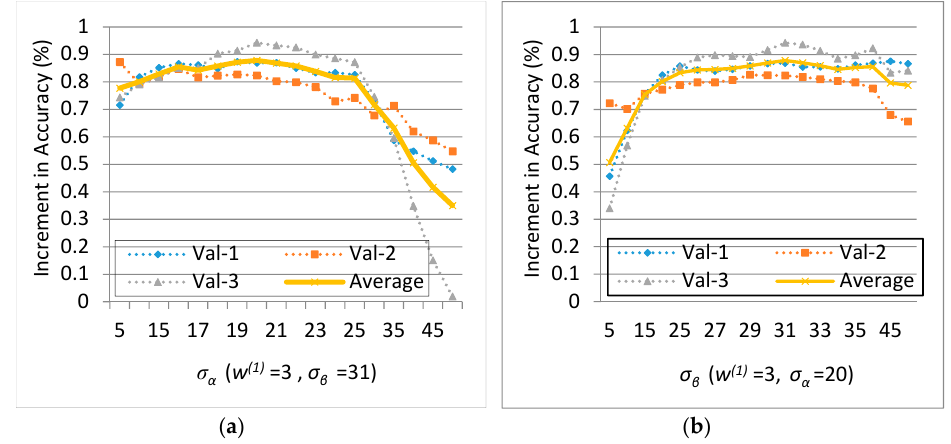
Figure 13. Influence of the hyper parameter values ( w ( 1 ) , σ α and σ β ) on the final classification accuracy. The experiment is implemented on the 3 tiles (named Val-1, Val-2 and Val-3) of the validation set. ( a ) Influence of σ α ; ( b ) influence of σ β